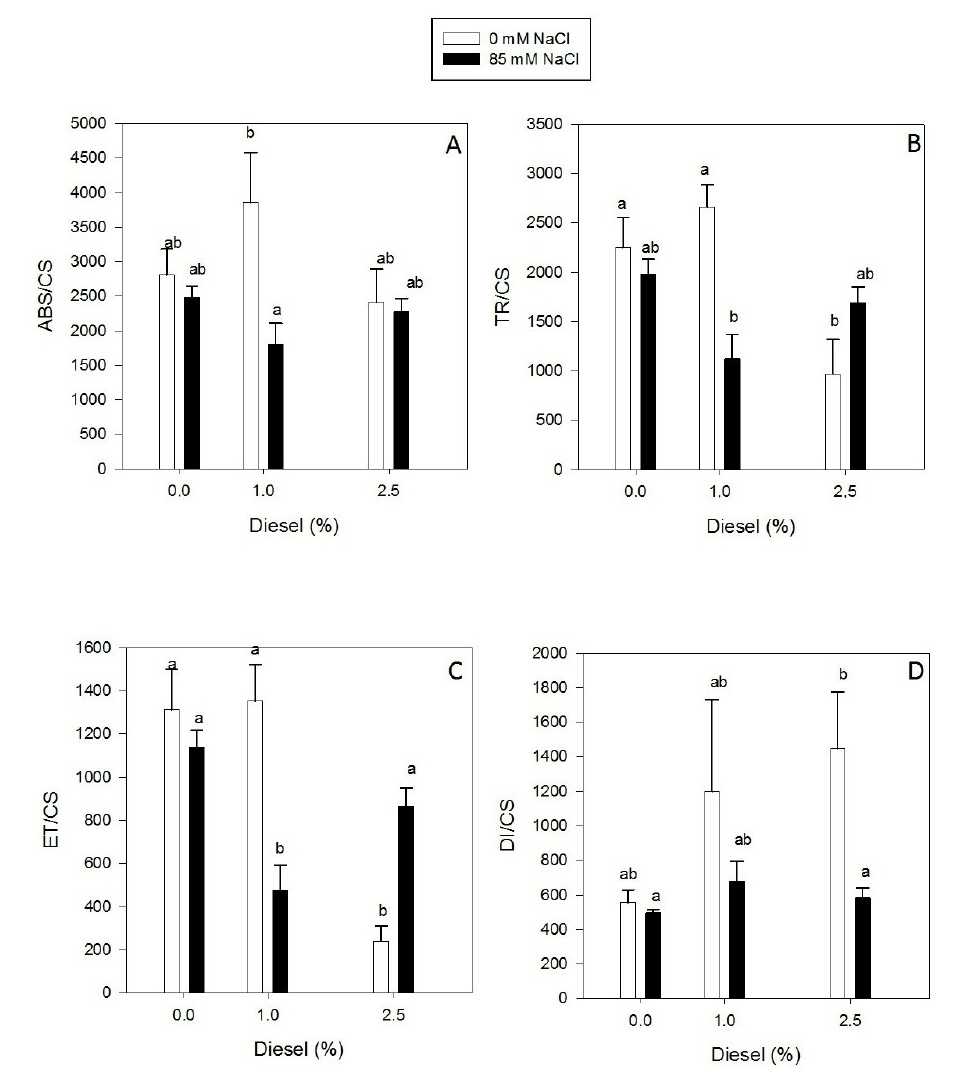
Figure 4. Absorbed energy flux, ABS/RC ( A ), trapped energy flux, TR/RC ( B ) electron transport energy flux, ET/RC ( C ), dissipated energy fluxes, DI/RC ( D ) per reaction center in dark-adapted randomly selected, primary branches of Juncus acutus in response to treatment with a range of diesel concentrations at 0 and 85.5 mM NaCl for 20 d. Values represent mean ± SE, n = 5. Different letters indicate means that are significantly different from each other (LSD, p <